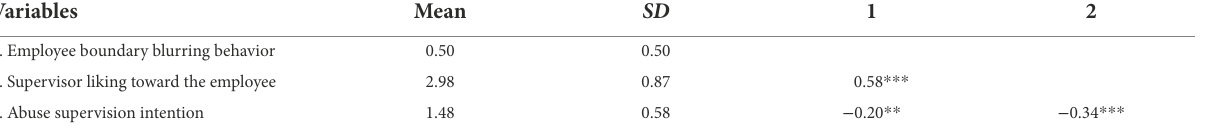
TABLE 1 Descriptive statistics and correlation coefficients of variables in Study 1. Variables